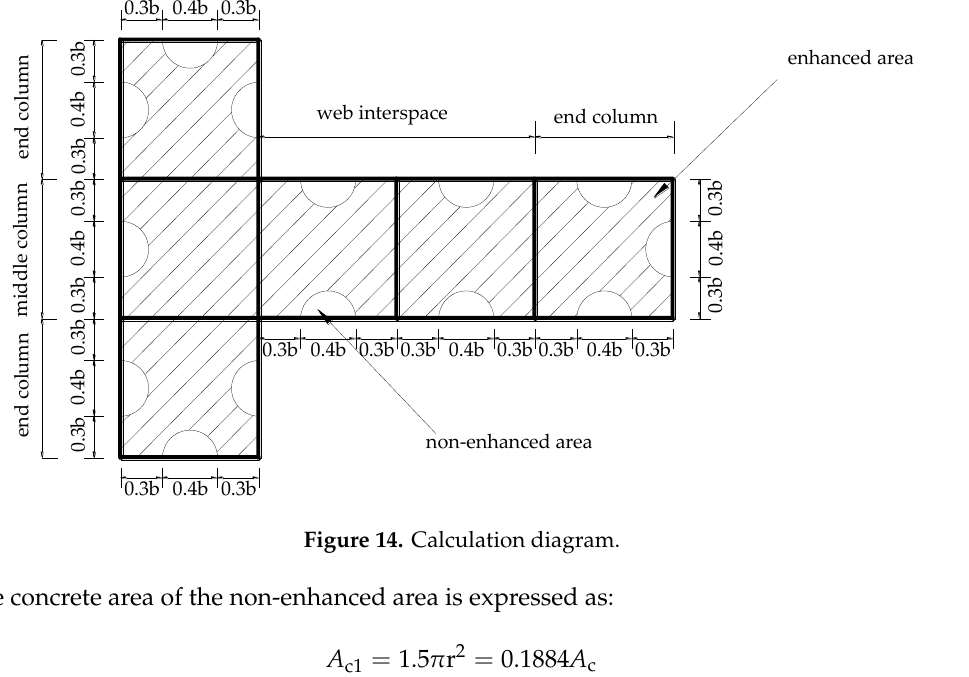
Figure 14. Calculation diagram.